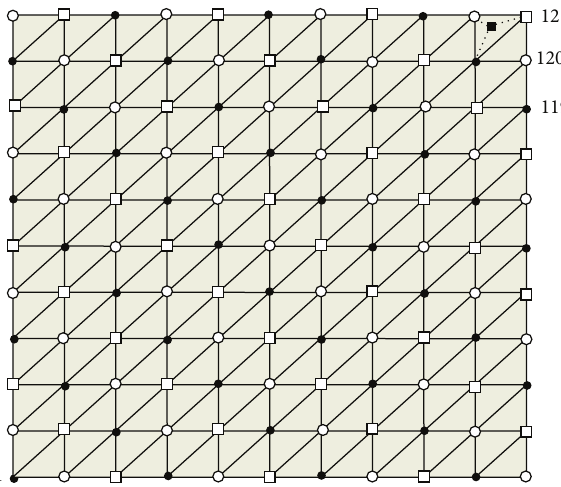
Figure 10: PEC plate mesh structure.